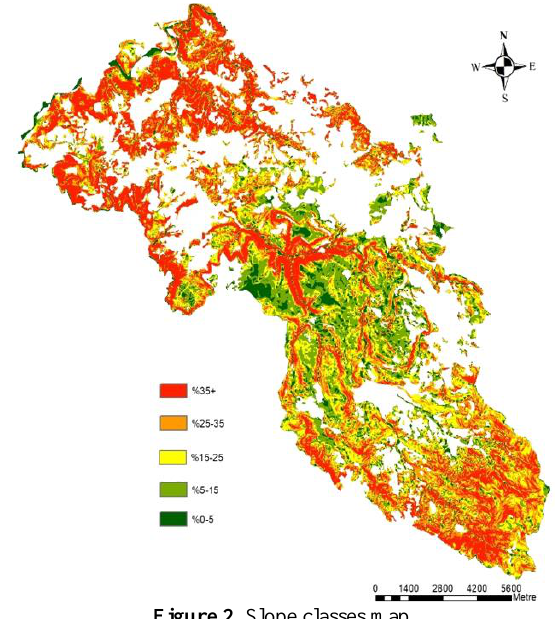
Figure 2. Slope classes